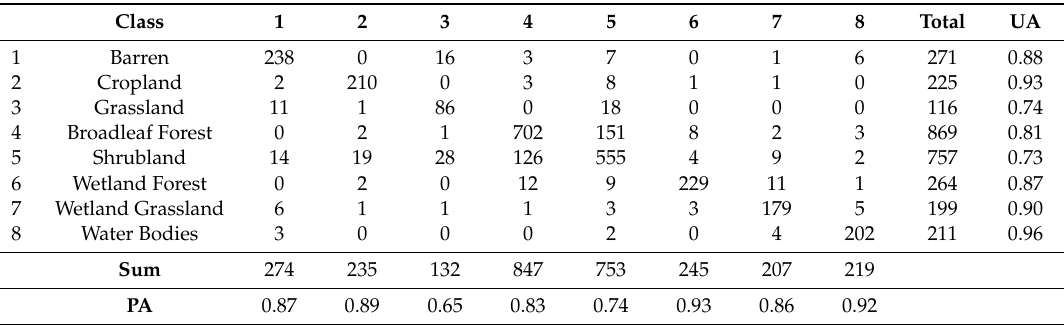
Table 3. Confusion matrix from the random forest classification using IGBP classes. The number of validation points is 2912, and the number of agreement points is 2401, with an overall accuracy of 0.82. Users’ Accuracy (UA) and Producers’ Accuracy (PA) is presented for each class.